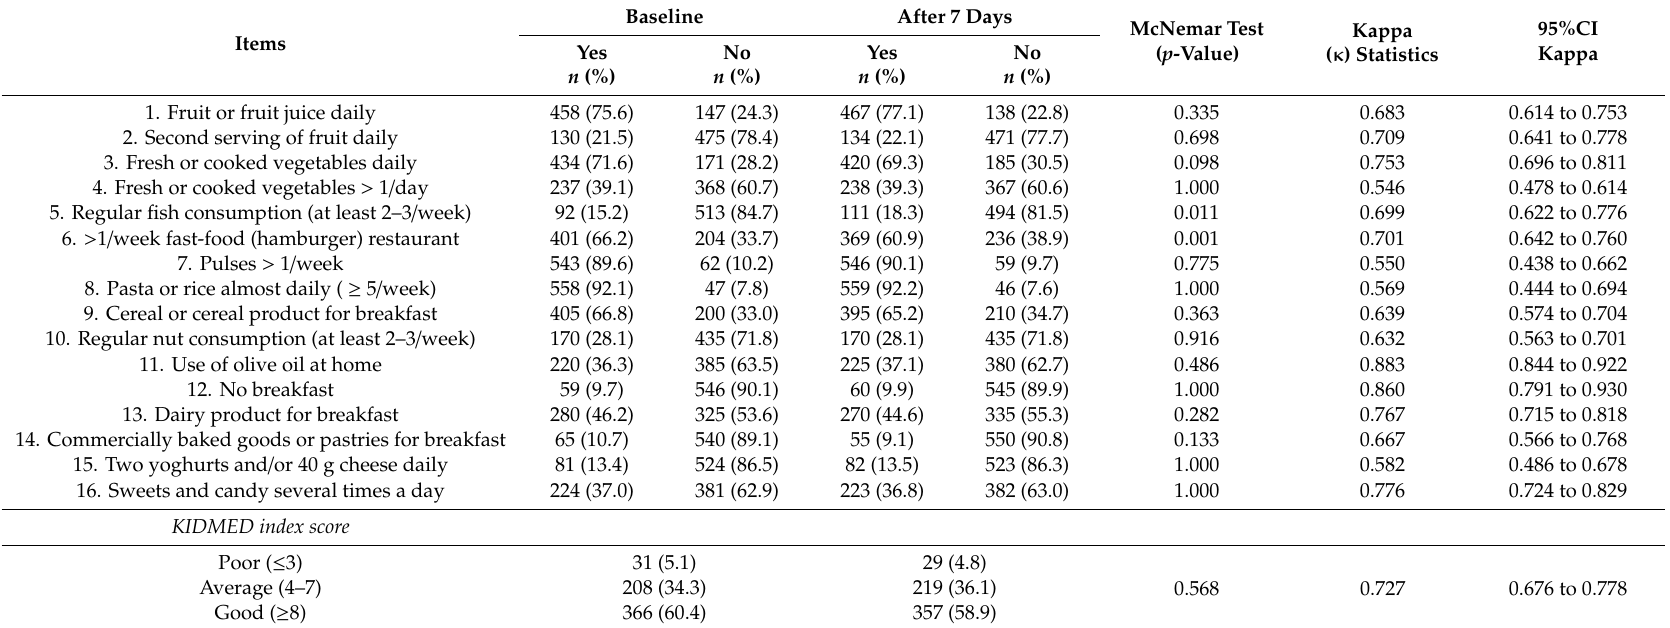
Table 2. Mediterranean Diet Quality Index statistics for the total